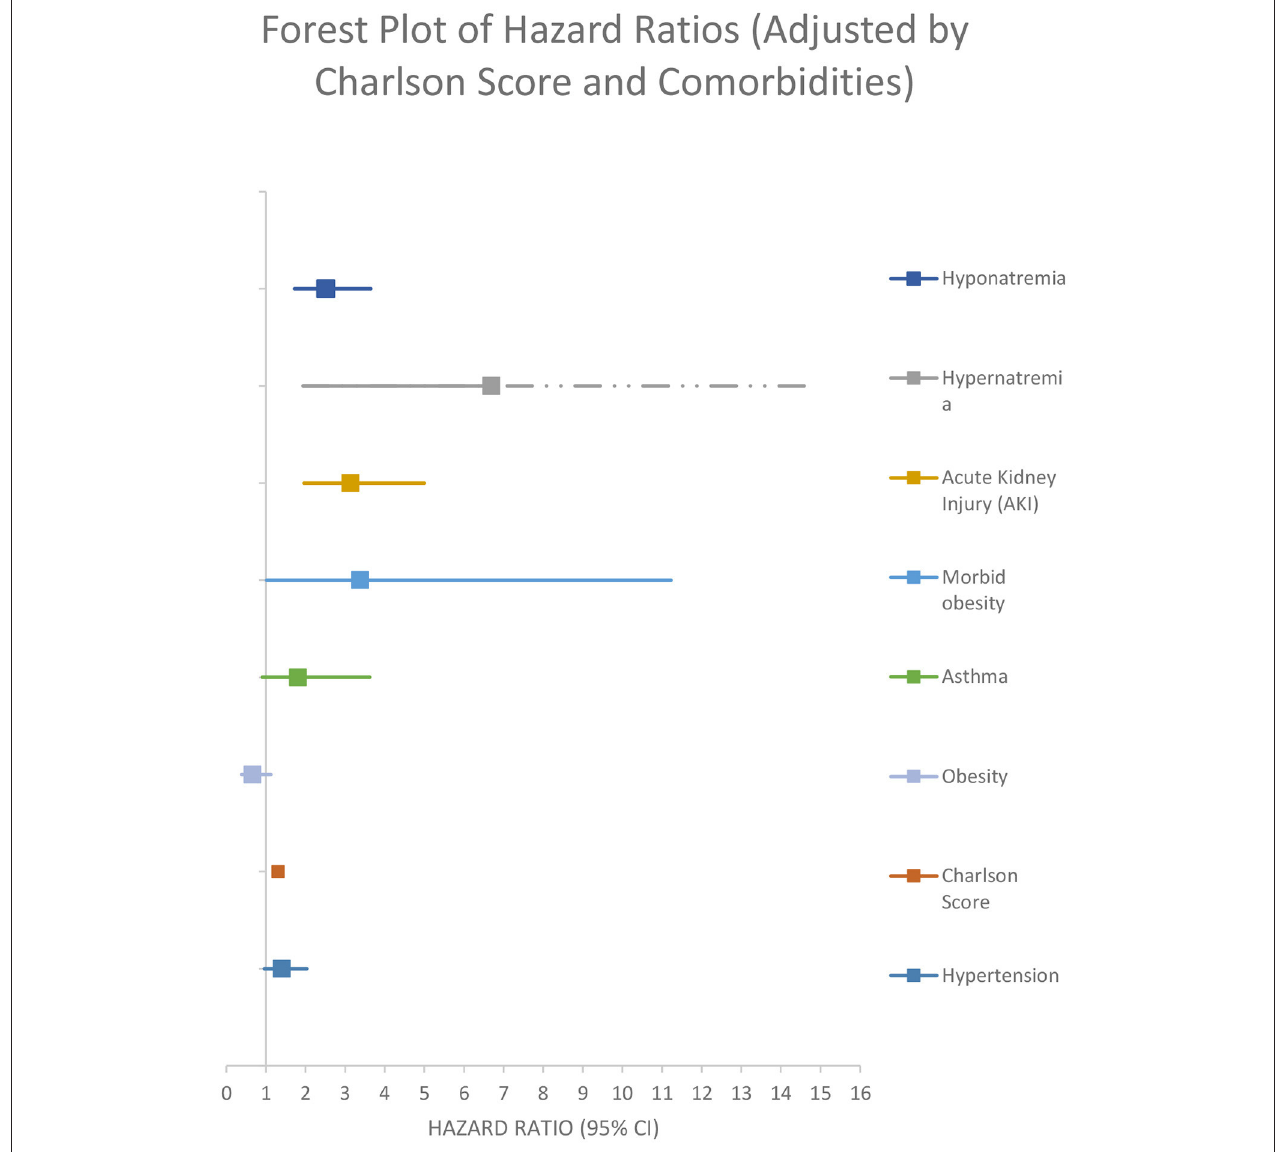
FIGURE 5 | Adjusted model by Charlson score and